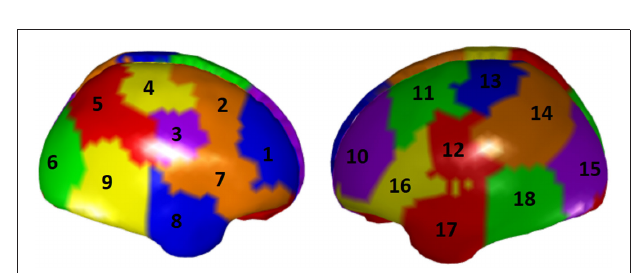
FIGURE 11 | A parcellation of the cortex superficial grid in 18 regions. Each color represents a region, and the regions has been numbered consecutively.